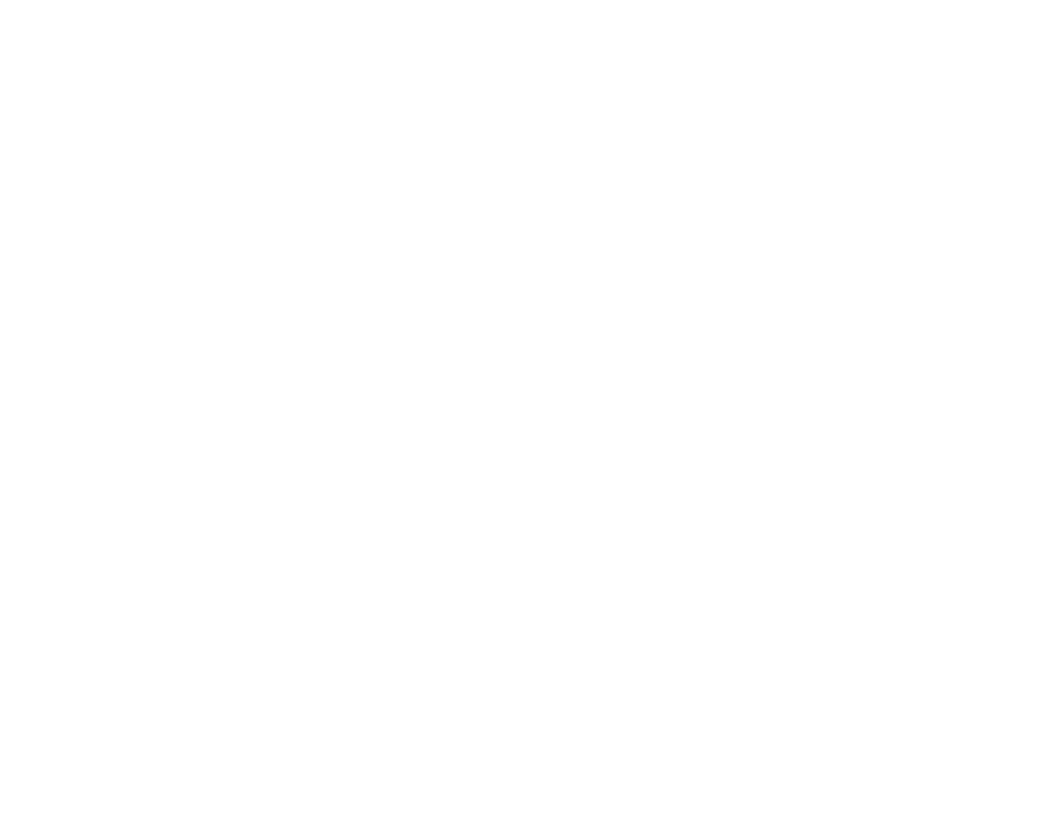
Figure 14. Extrapolation performance of